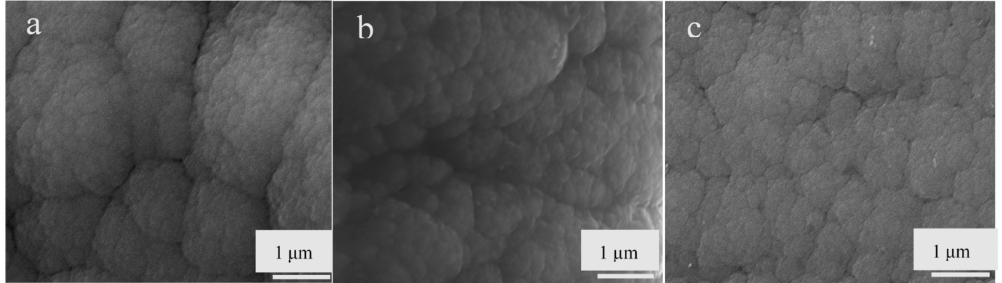
Figure 1. SEM images of the surface of coatings ( a ) G1; ( b ) G2; and ( c )